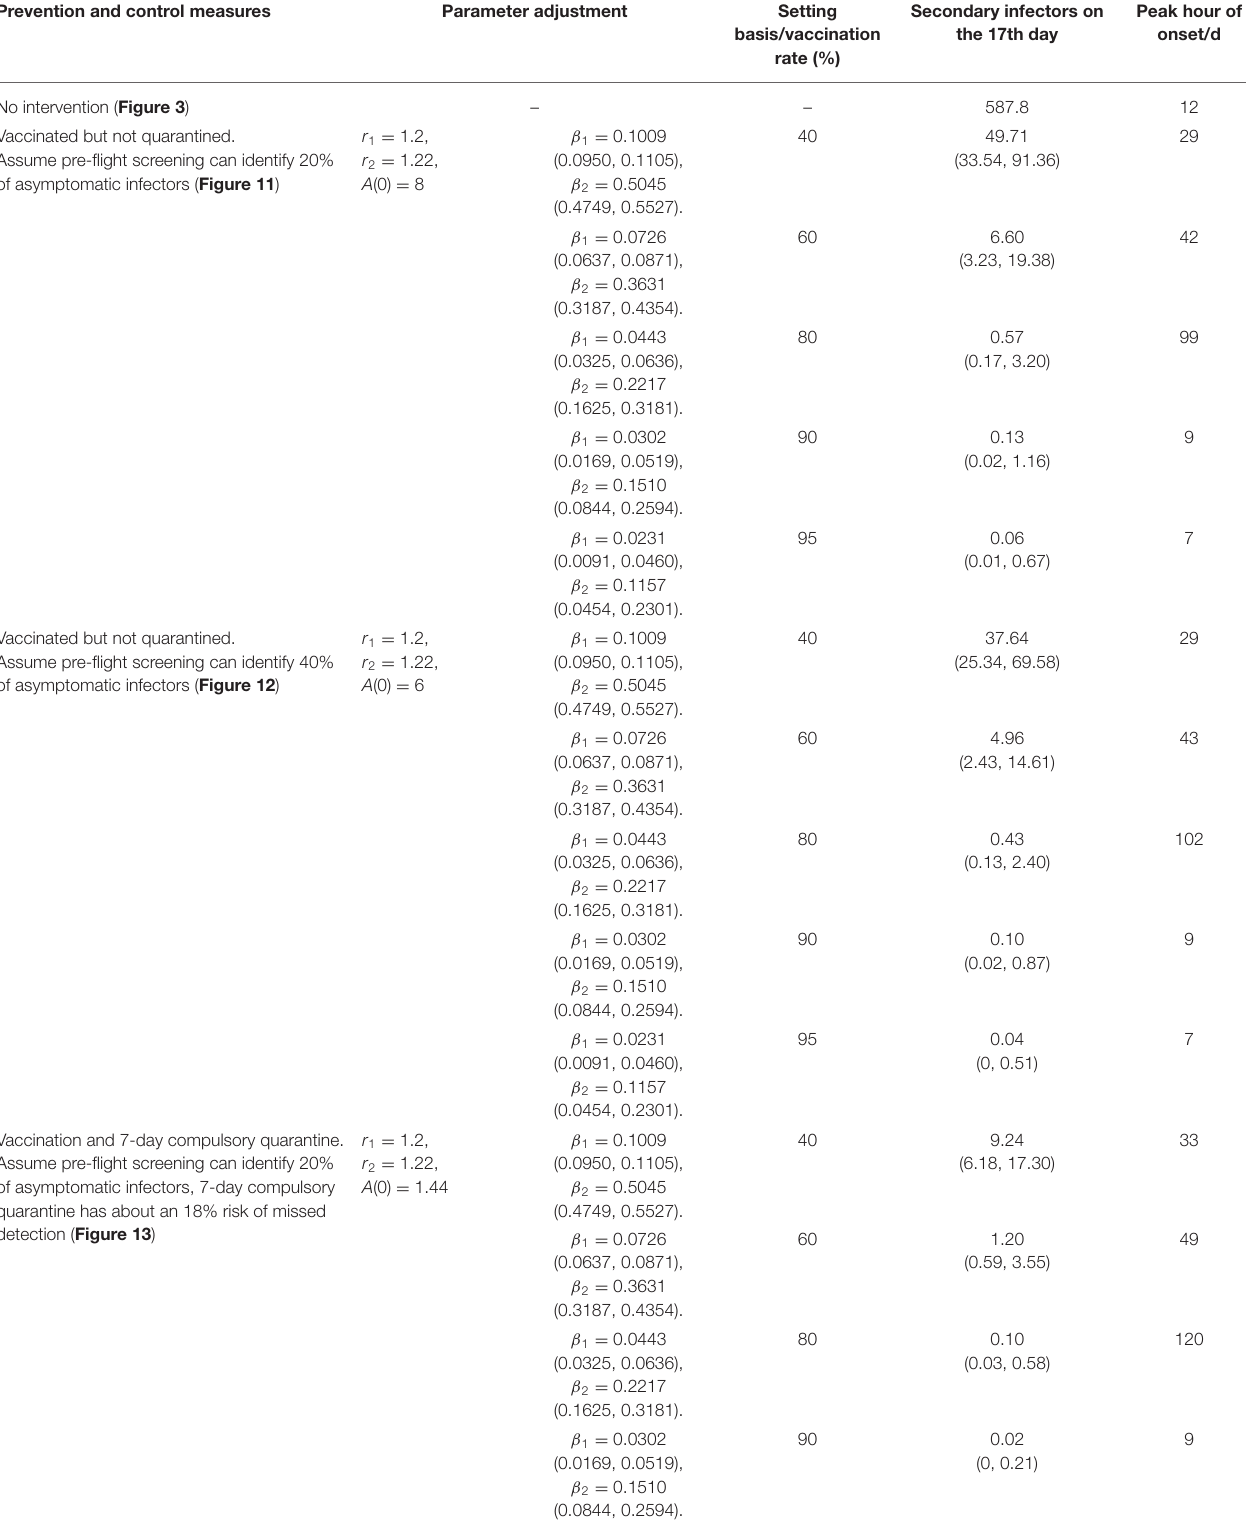
TABLE 6 | Parameter adjustment (Consider differences in population